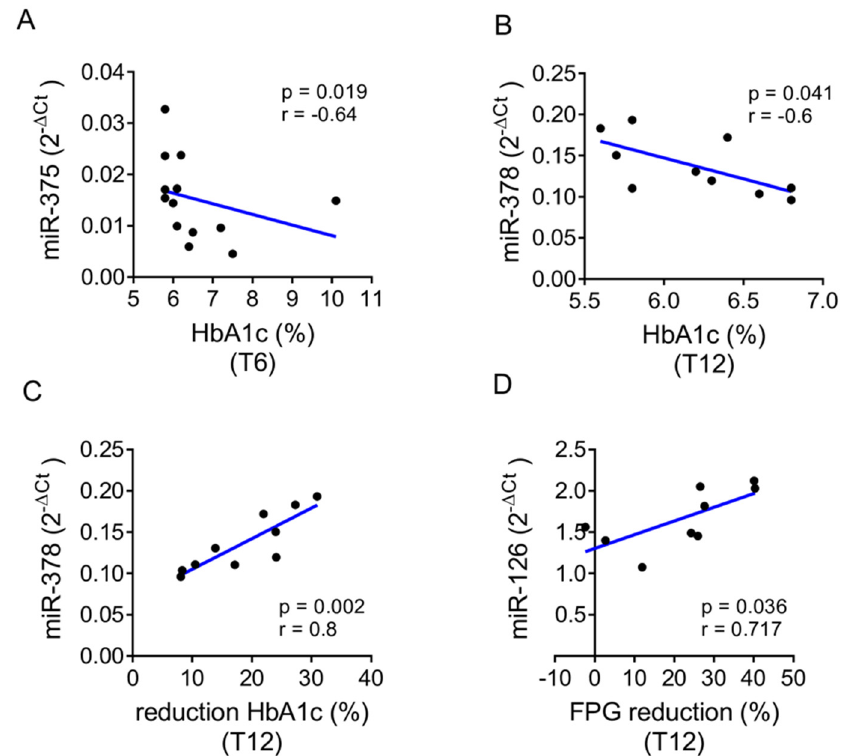
Figure 4. ( A – D ) Dot plot graphs of correlations between baseline miRNAs expression levels and metabolic parameters at follow-up in high expressing group. Baseline expression levels of miR-375-3p ( A ) plotted with HbA1c levels assessed at T6, of miR-378a-3p ( B , C ) with HbA1c levels and percentage reduction of HbA1c assessed at T12, respectively, and of miR-126-3p ( D ) with percentage reduction of FPG as assessed at T12.